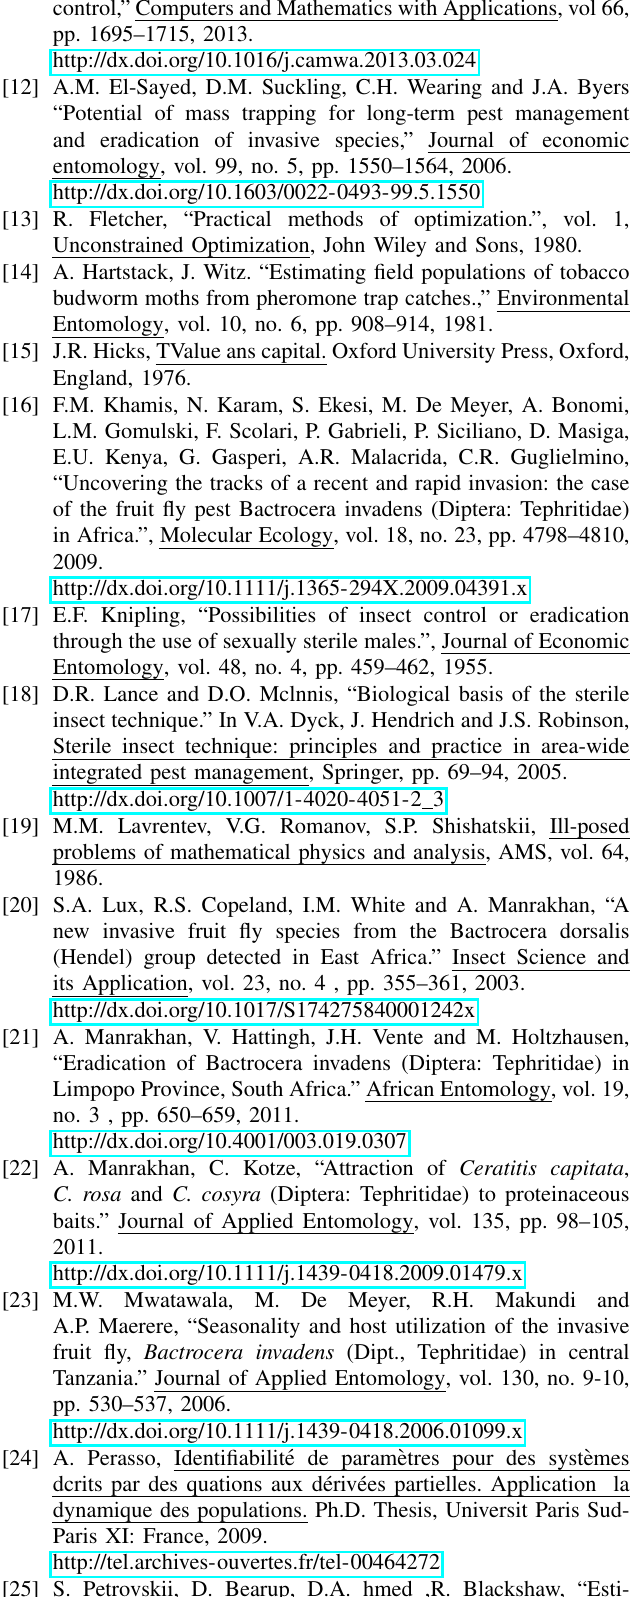
C Dufourd et al., Parameter Identification in Population Models for Insects Using Trap